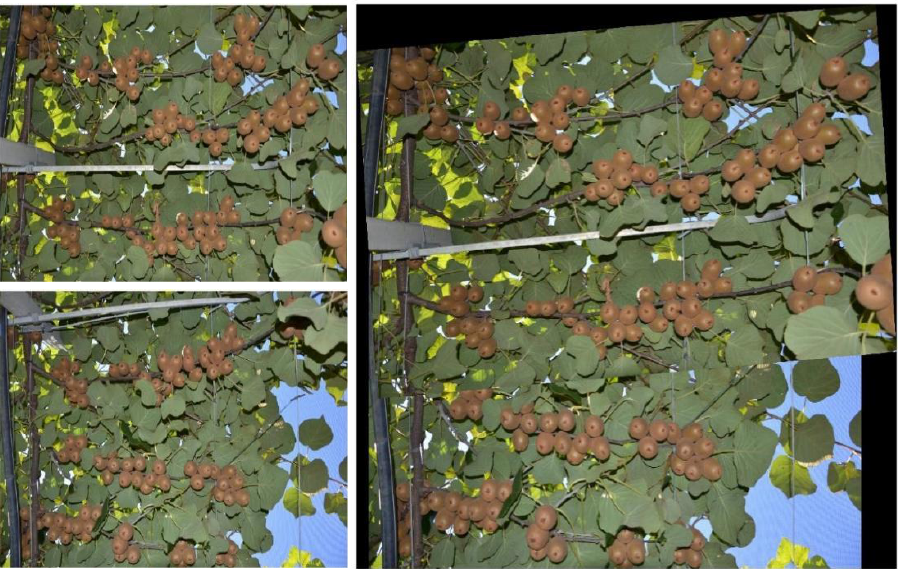
Figure 6. Image stitching example. ( Top left ): first image, ( Bottom left ): second image, ( Right ): stitched images.